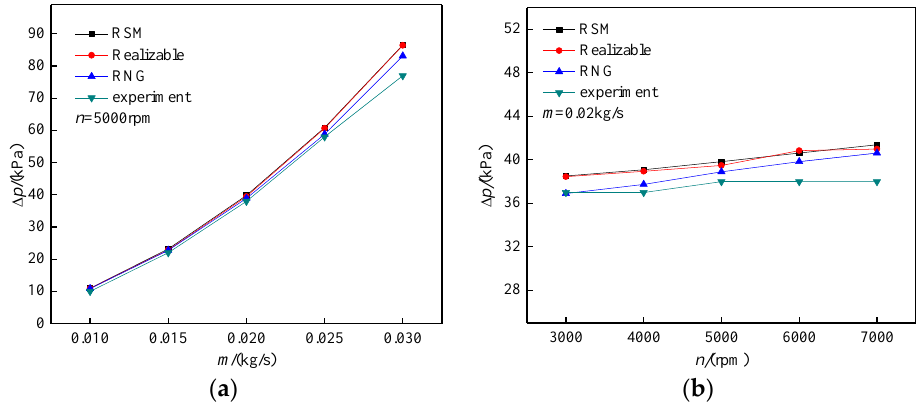
Figure 5. Single-phase model validation. ( a ) Ventilation rate; ( b ) rotating speed.